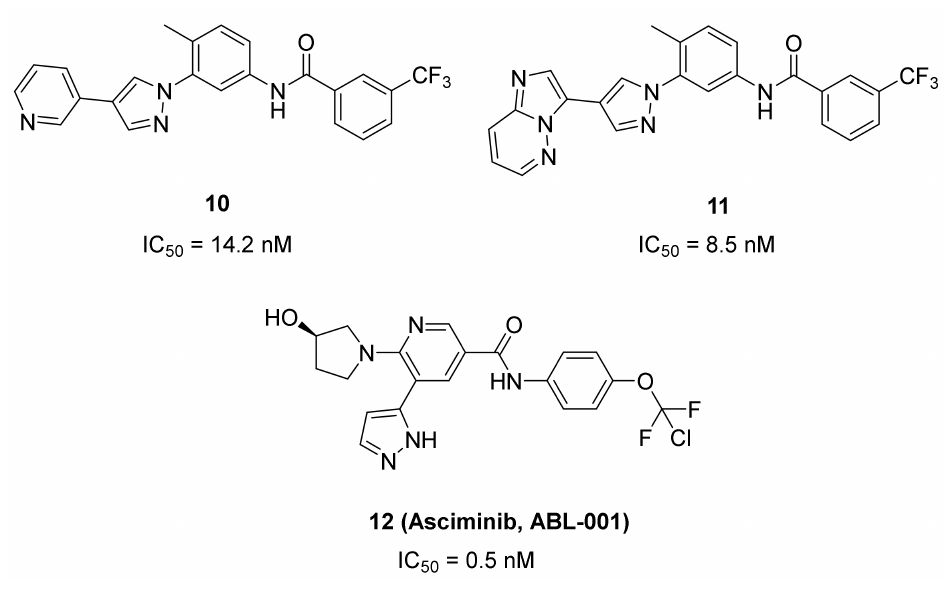
Figure 18. Structures of pyrazole-based BCR-ABL kinase inhibitors and their IC 50 values.